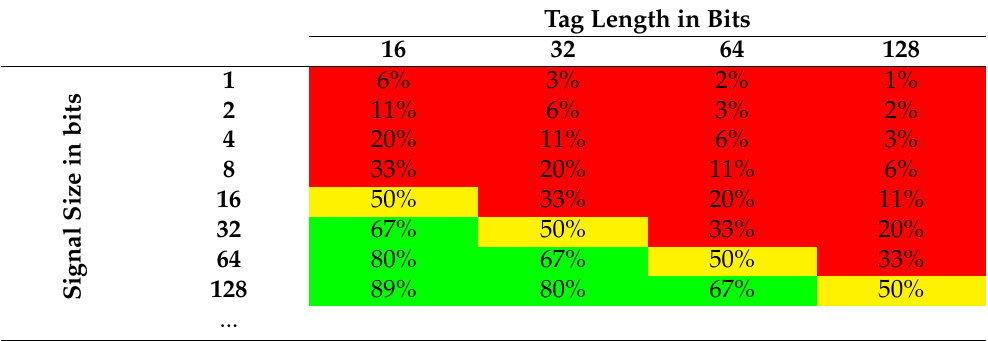
Table 2. Utilization percentages of communication buses using different tag lengths and signal